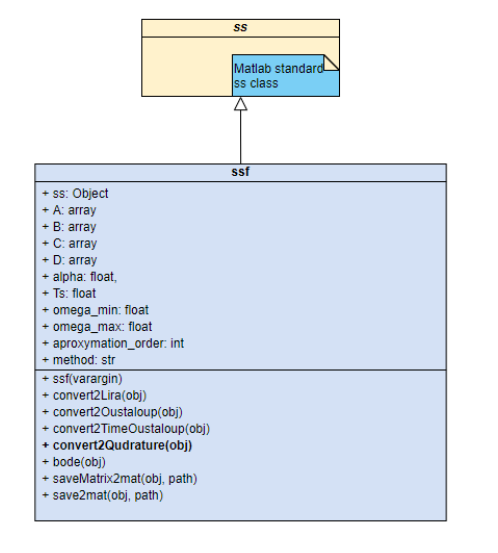
Figure 2. ssf class inherits from MATLAB ® Control Systems Toolbox TM ss . Its methods allow model conversion and typical functions.